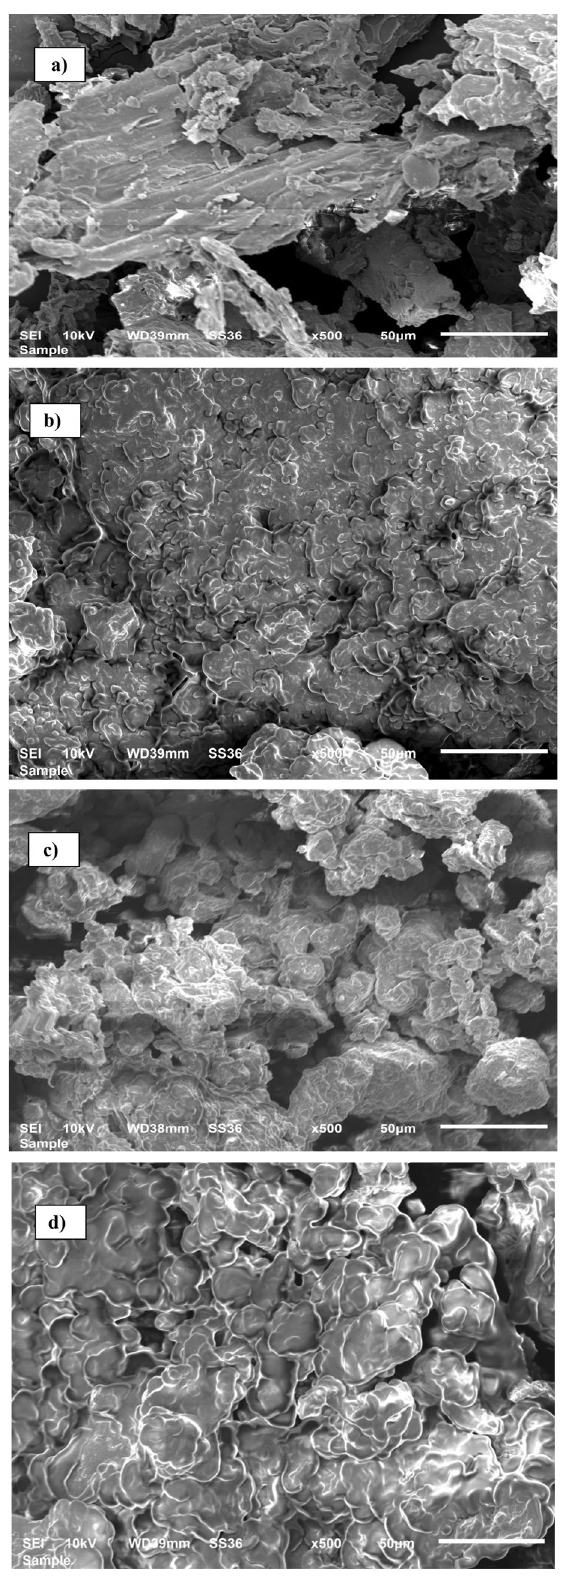
Figure 2. SEM images of ( a ) FVESP and ( b ) Zn-FVESP and ( c ) Ox-FVESP and ( d )